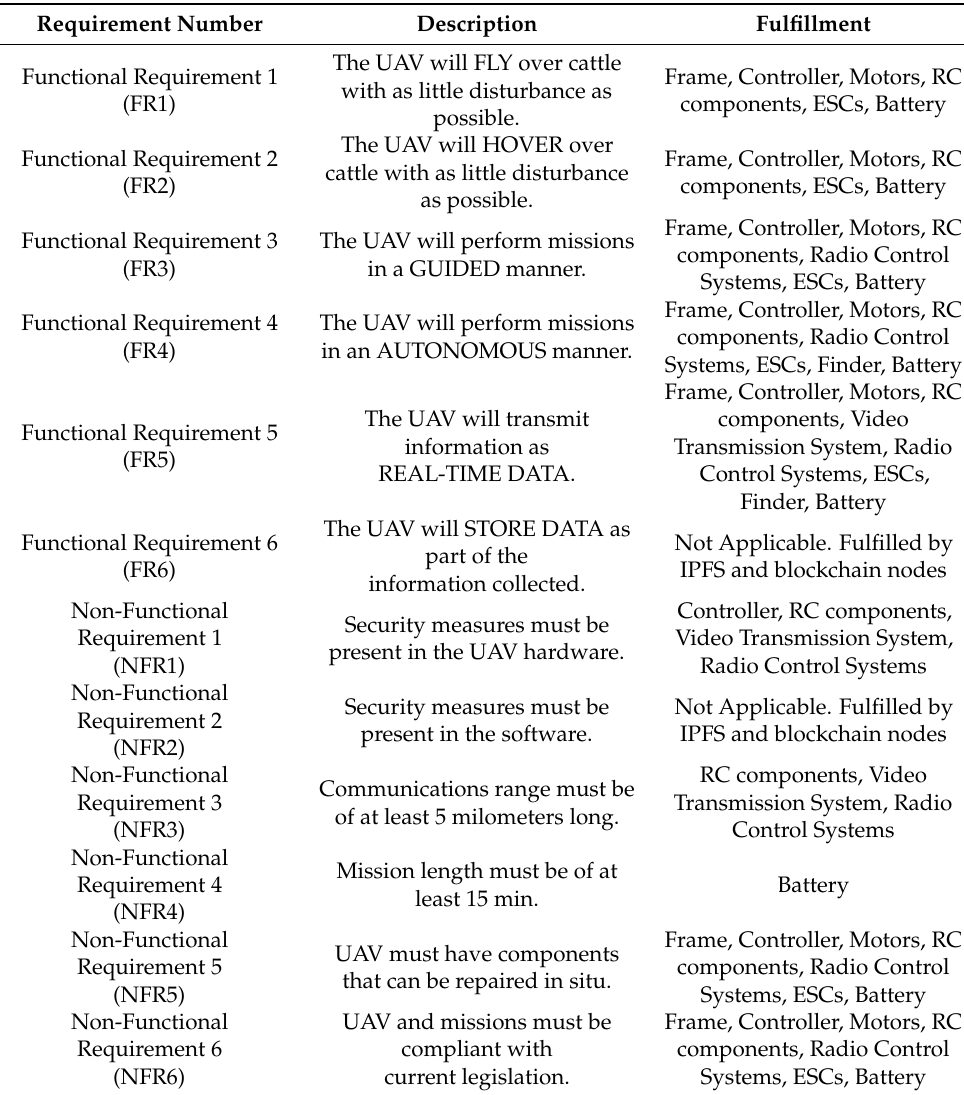
Table 6. Fulfillment of some functional and non-functional requirements with the